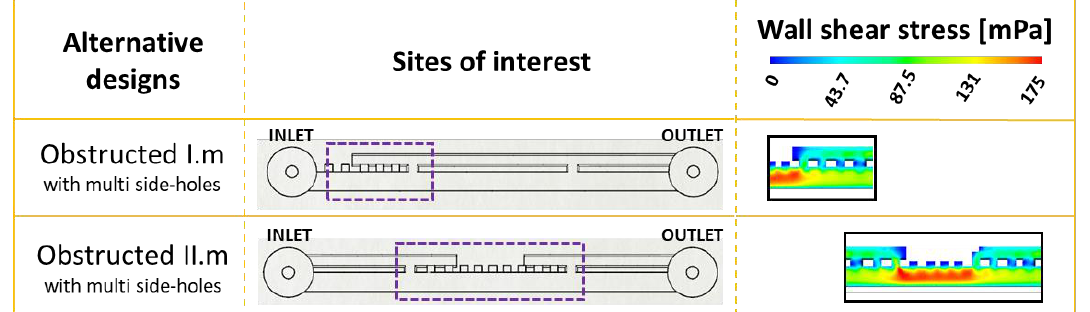
Figure 5. Manufacturing multiple side-holes in proximity to a ureteral obstruction decreases the possibility of bacterial attachment by enhancing fluid drainage and wall shear stress levels near the occlusion. The same designs that caused bacterial attachment (obstructed I and obstructed II) were modified to contain multiple side-holes close to the obstruction. As assessed by CFD simulations, the addition of side-holes increases the magnitude of WSS in regions that were previously subject to cavity